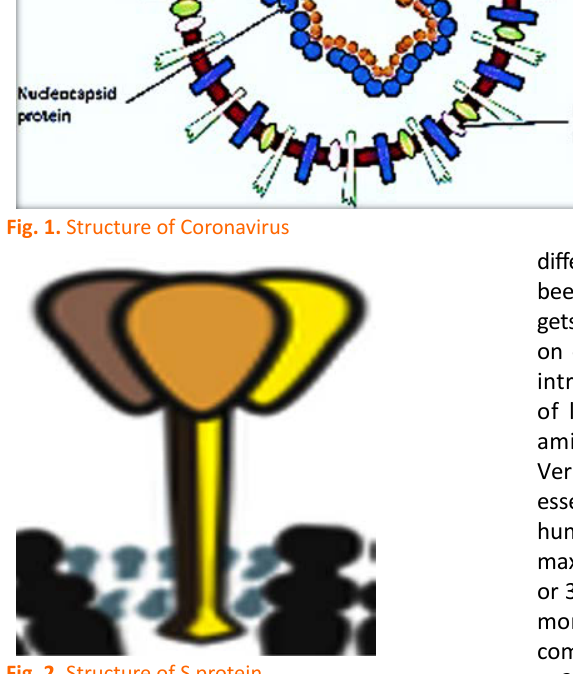
Fig. 2. Structure of S protein